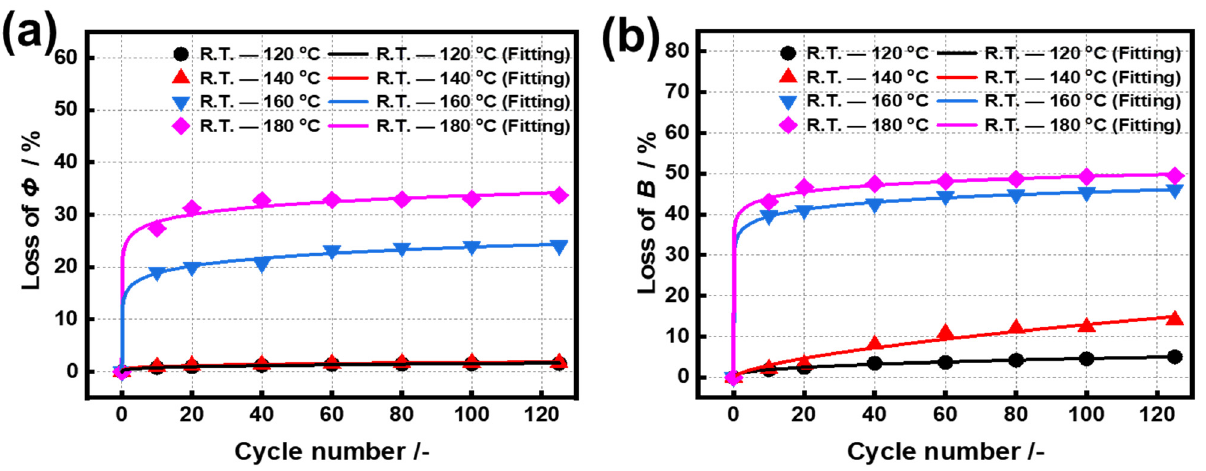
Figure 2. Losses of ( a ) Φ and ( b ) B of the samples cycled in ranges of R.T. to 120, 140, 160, and 180 ◦ C, respectively. The lines in figures are the fitting curves with a formula Y = A × ( X − X c ) P . The formula Y = A × ( X − X c ) P is applied to fit the experimental data, where Y represents the losses of Φ or B , and X is the cycle number, and A , X c and P are the fitting parameters. The fitting curves are shown in Figure 3b,d, and the values of the fitted parameters are given in Table 2. All the curves exhibit good fitting results with R 2 ≥